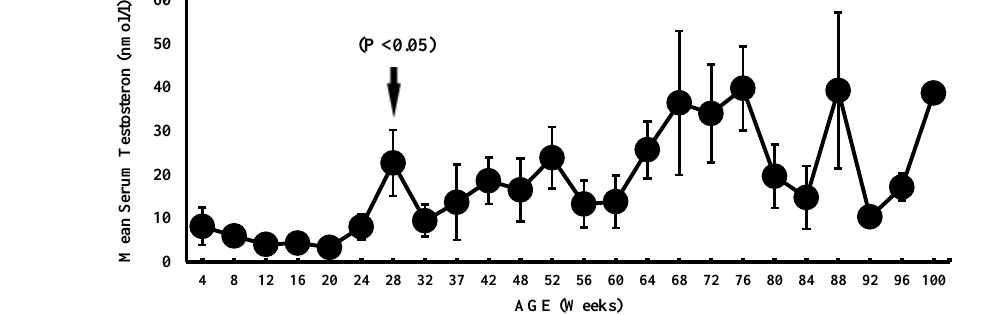
Figure 4. Mean serum testosterone levels from birth until the 100th week of age in the common marmoset ( n = 48). Note the first significant ( P < 0 . 05) (arrow) rise in the mean serum testosterone at the 28th week of age as compared to 24, 20 and 16 weeks of age, followed by continuously high serum testosterone levels observed